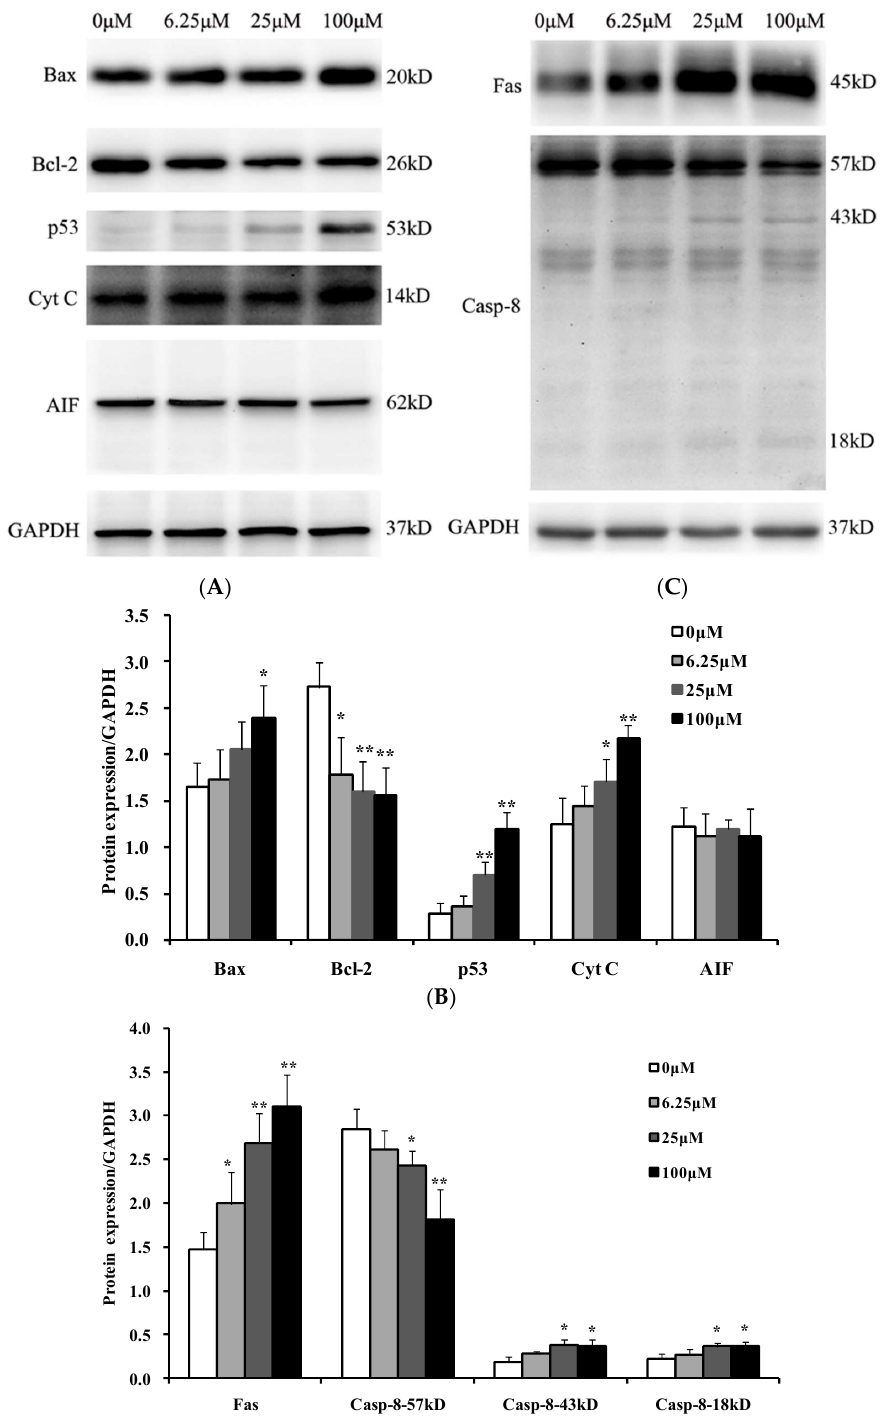
Figure 4. Effects of luteoloside on the apoptosis-related proteins of Hela cells. ( A , C ) Protein samples of the Hela cells treated with 0, 6.25, 25, and 100 μM luteoloside for 24 h were subjected to Western blot analysis. Glyceraldehyde-3-phosphate dehydrogenase (GAPDH) served as the internal control. Shown are representative results of three independent experiments. ( B , D ) The relative expression of proteins compared with GAPDH. Cyt C: cytochrome C. AIF: apoptosis-inducing factor. Casp-8: Caspase-8. * p < 0.05, ** p < 0.01, versus the control group (0 μM luteoloside). 2.4. Luteoloside Induces Apoptosis of Hela Cells through the Death Receptor Pathway